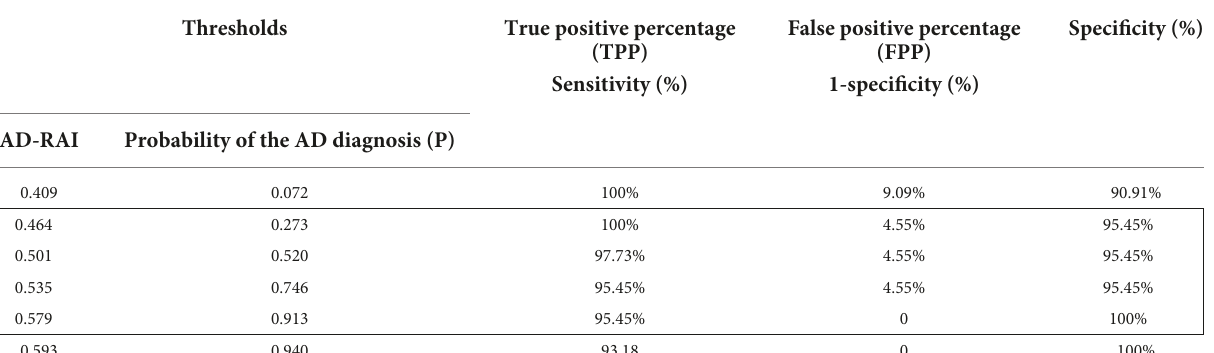
TABLE 4 Sensitivity, FPP and specificity at different decision thresholds of AD-RAI.